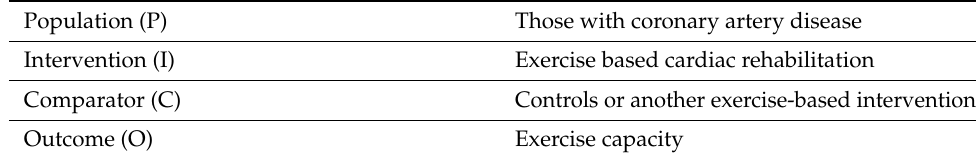
Table 1. PICO for the search